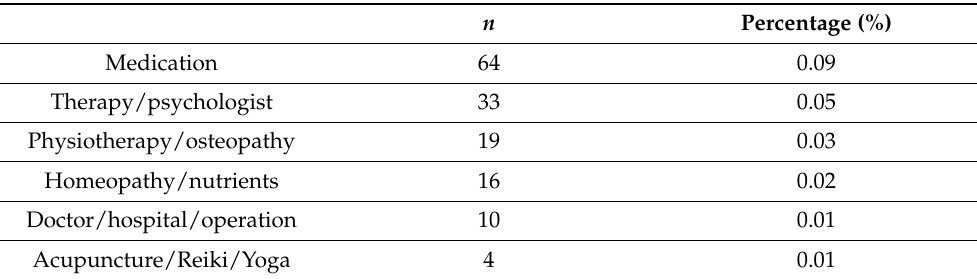
Table 3. Frequency Table How Handled Somatic Complaints 1 ( N =